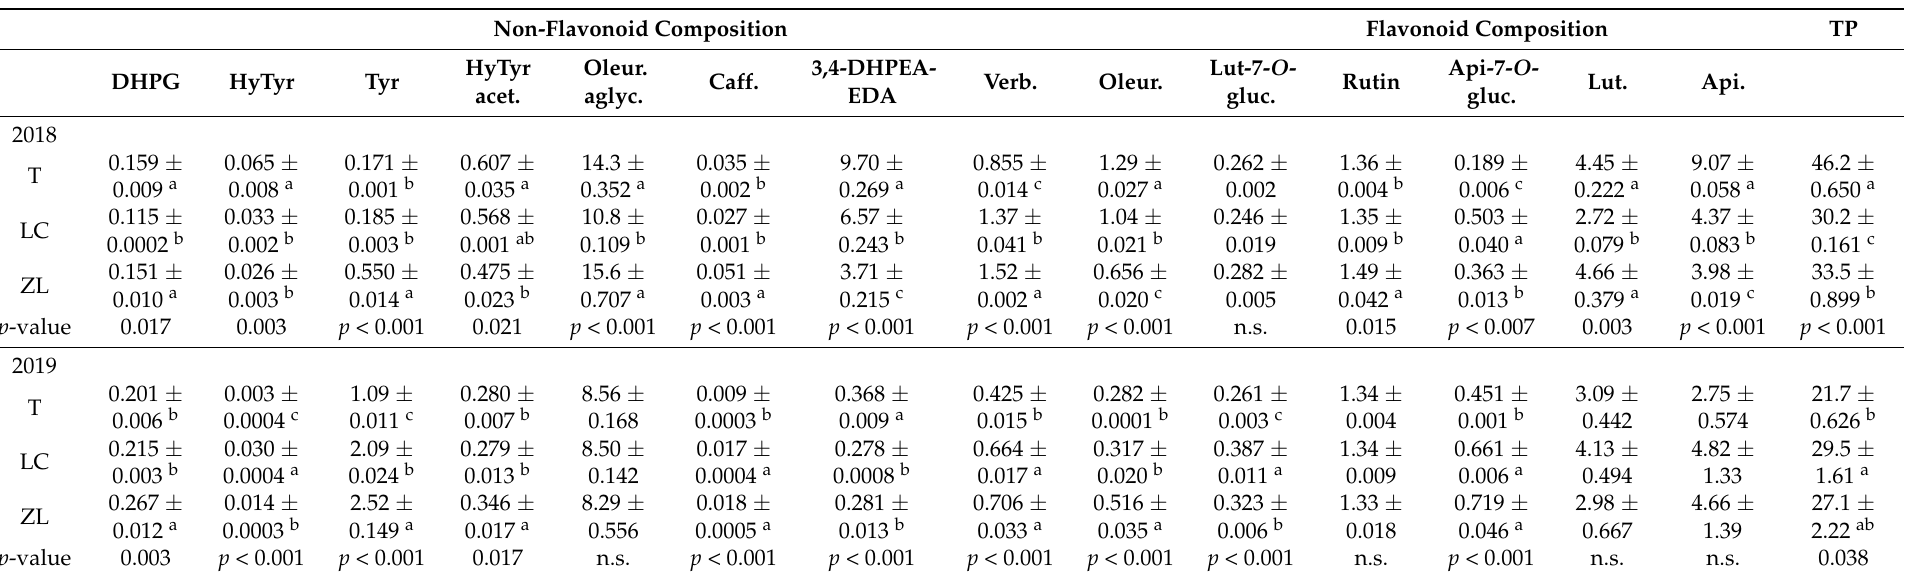
Table 6. Olive oil polyphenolic composition as a function of soil management treatment and harvest year. 3,4-Dihydroxyphenylglycol (DHPG); hydroxytyrosol (HyTyr); tyrosol (Tyr); hydroxytyrosol acetate (HyTyr acet.); oleuropein aglycone (Oleur. aglyc.); caffeic acid (Caff.); 3,4-DHPEA-EDA (dialdehydic forms of decarboxymethyl elenolic acid linked to hydroxytyrosol); verbascoside (Verb.); oleuropein (Oleur.); luteolin-7- O -glucoside (Lut.-7- O -gluc.); rutin; apigenin-7- O - glucoside (Api.-7- O -gluc.); luteolin (Lut.), apigenin (Api.) and total phenols (TP) (mg kg − 1 DW). Non-Flavonoid Composition Flavonoid